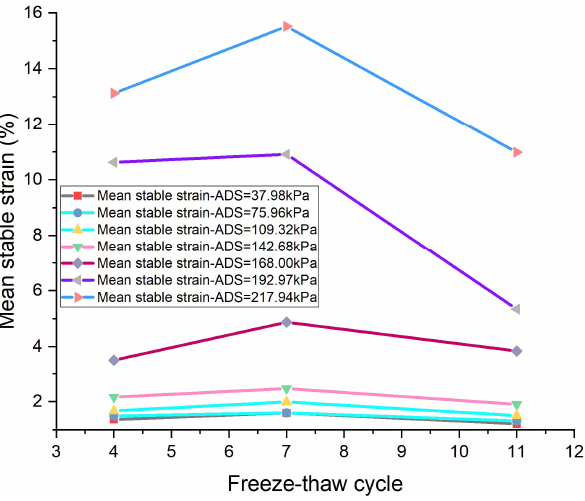
Figure 31. Mean stable strain–FTH under confining pressure = 150 kPa and the preset ADS. The mean stable strain of 7 FTHs is always higher than it of 4 FTHs and 11 FTHs, while that of 4 FTHs is not always higher than that of 11 FTHs, such as when ADS = 168.00 kPa. Though there were only three FTHs set in the experiment, as it may not be perfect to assess the effect of comprehensive FTHs on the stable strain, the correlations of 4, 7 and 11 FTHs are still fitted and provided.